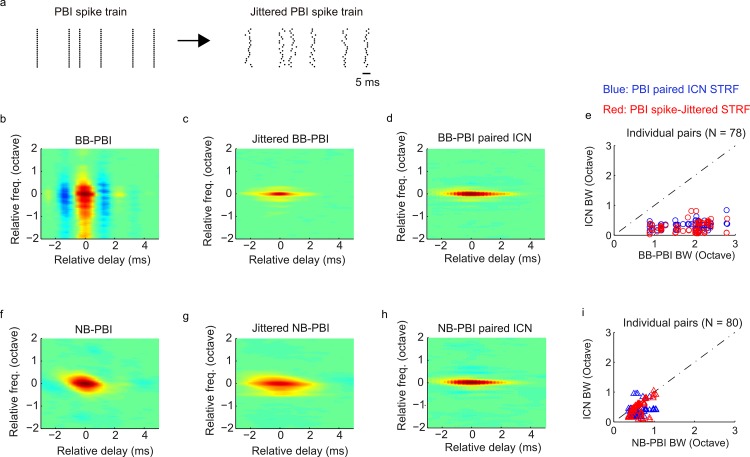
Reduced spike-timing precision enhances frequency selectivity of broadband PBIs but not for narrowband PBIs.(a) Synthetic spike-timing jitter (1.5 ms) was added to each of the PBI spike trains, and the STRF was recomputed. Although the population-average broadband PBI is broadly tuned (b), the jittered broadband PBI is substantially narrower (c) and closely matches the population-average ICN STRF at those sites (d). This enhanced frequency selectivity was evident after adding spike-timing jitter for each of the individual broadband PBIs (panel e, red dots: broadband PBI versus jittered broadband PBI bandwidth) and closely matched the observed measurements for individual paired broadband PBIs and ICNs (panel e, blue dots: broadband PBI versus ICN bandwidth). This behavior was not evident for narrowband PBIs (f–i) because the population-average STRF bandwidth was similar before (f) and after (g) adding spike-timing jitter. Furthermore, bandwidths before and after adding spike-timing jitter for individual narrowband PBIs (i) were significantly correlated (r = 0.6 ± 0.12), implying that the bandwidth after adding spike-timing jitter was largely inherited from the original narrowband PBI. Underlying data can be found in S6 Data and S6 Code. BB, broadband; ICN, inferior colliculus neuron; NB, narrowband; PBI, putative brainstem input; STRF, spectrotemporal receptive field.